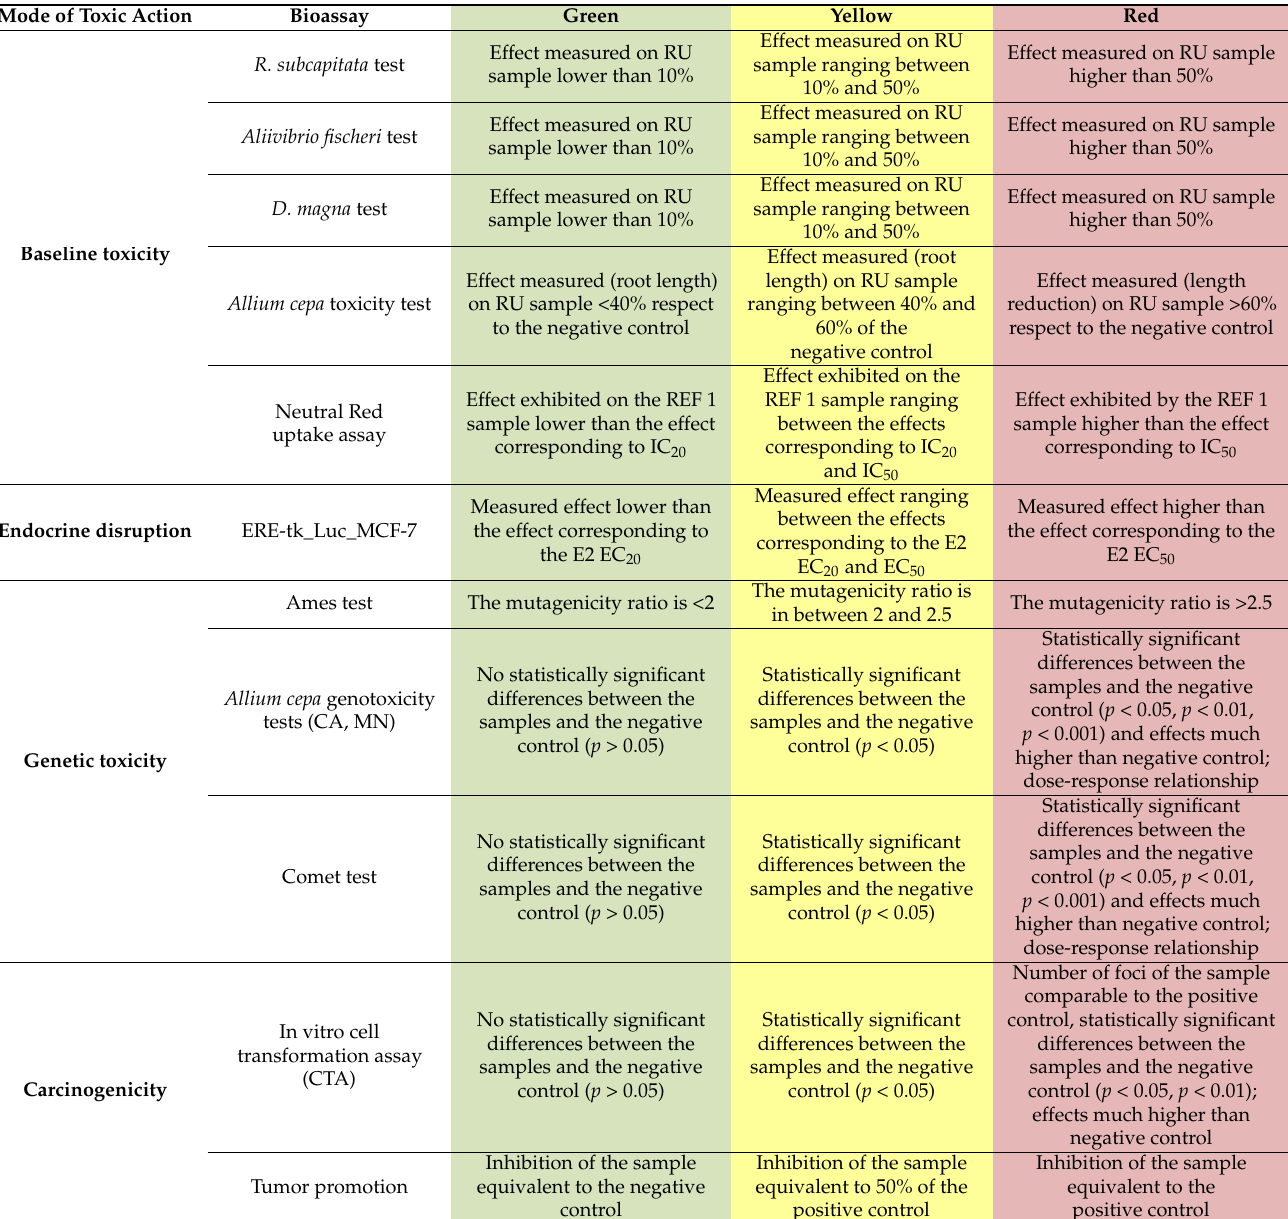
Table 1. Criteria adopted for color attribution to experimental results (E2 = 17 β -estradiol; type of sample: REF = relative enrichment factor, as defined in the main text; RU = raw